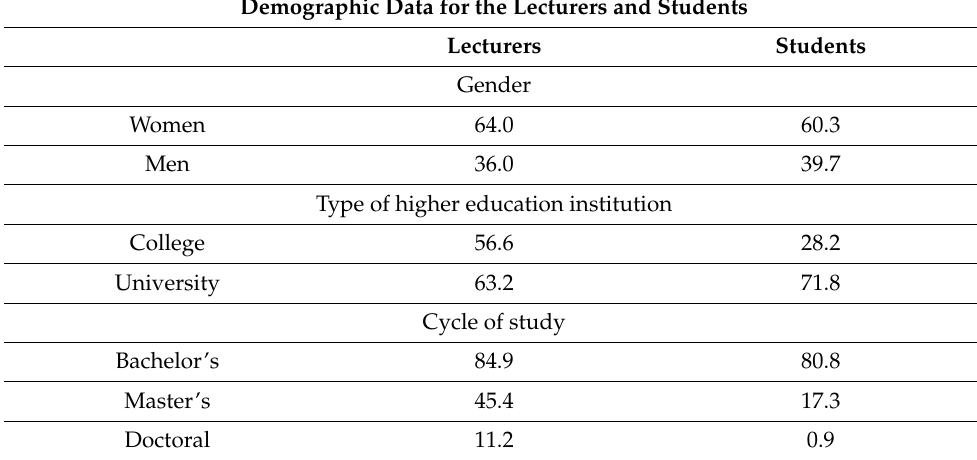
Table 1. Sociodemographic data for the lecturer and student groups (%). Demographic Data for the Lecturers and